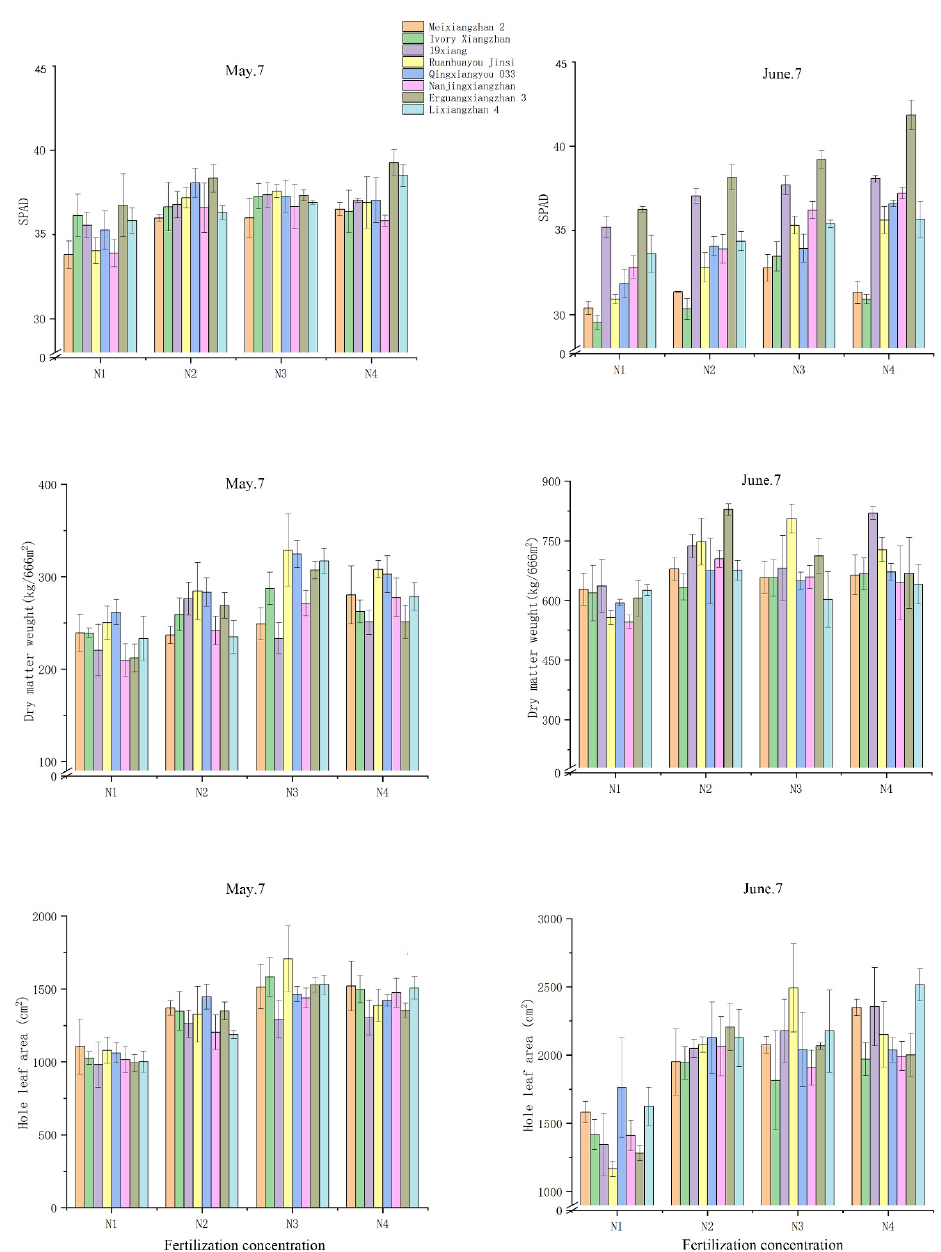
Figure 4. Physiological parameters of peanut under different nitrogen application levels and growth stages.